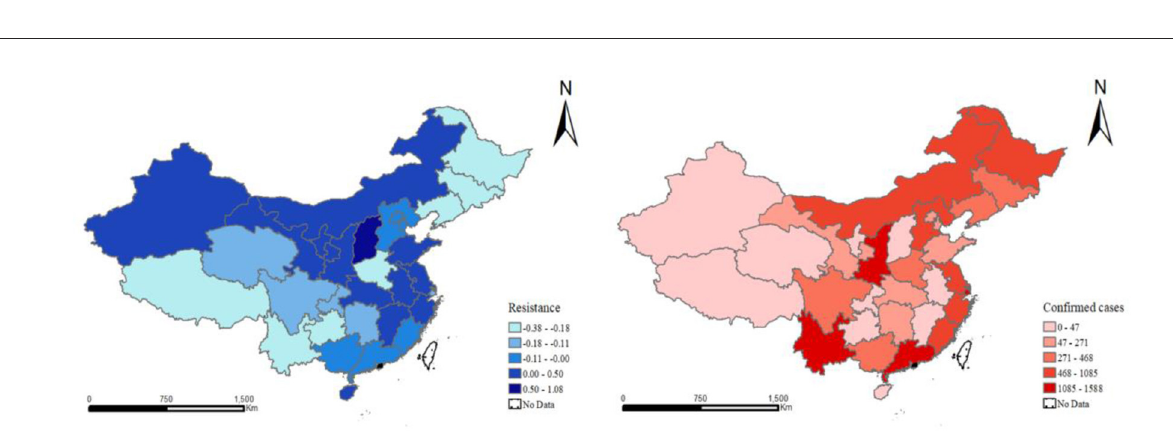
epidemic, coastal provinces have restricted human activities and adopted a lifestyle of “working from home and taking online classes.” This has inevitably led to social and